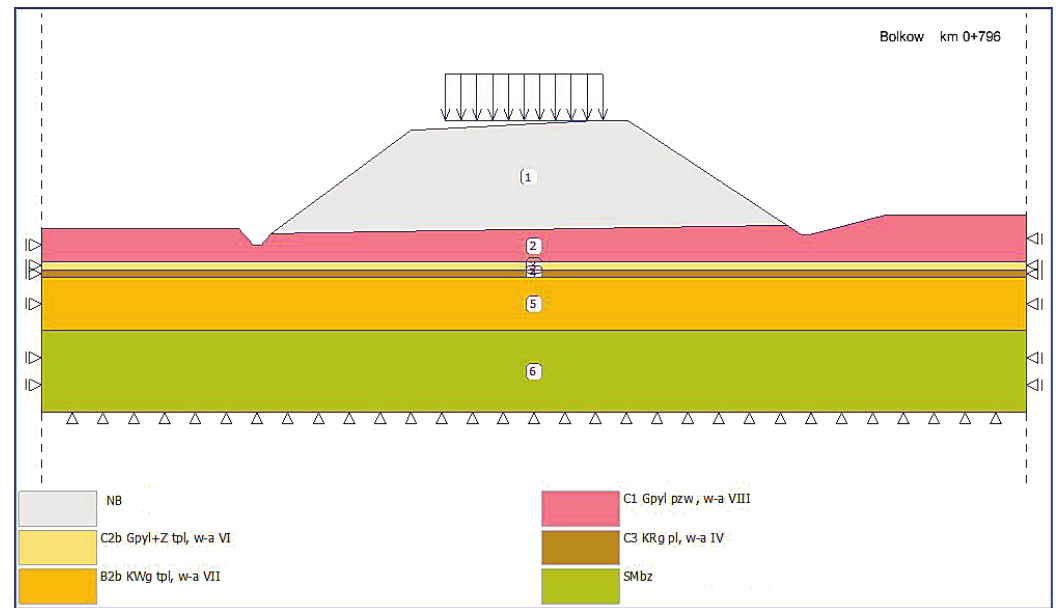
Figure 4. Cross section of km 0 + 796.18 – computational scheme.